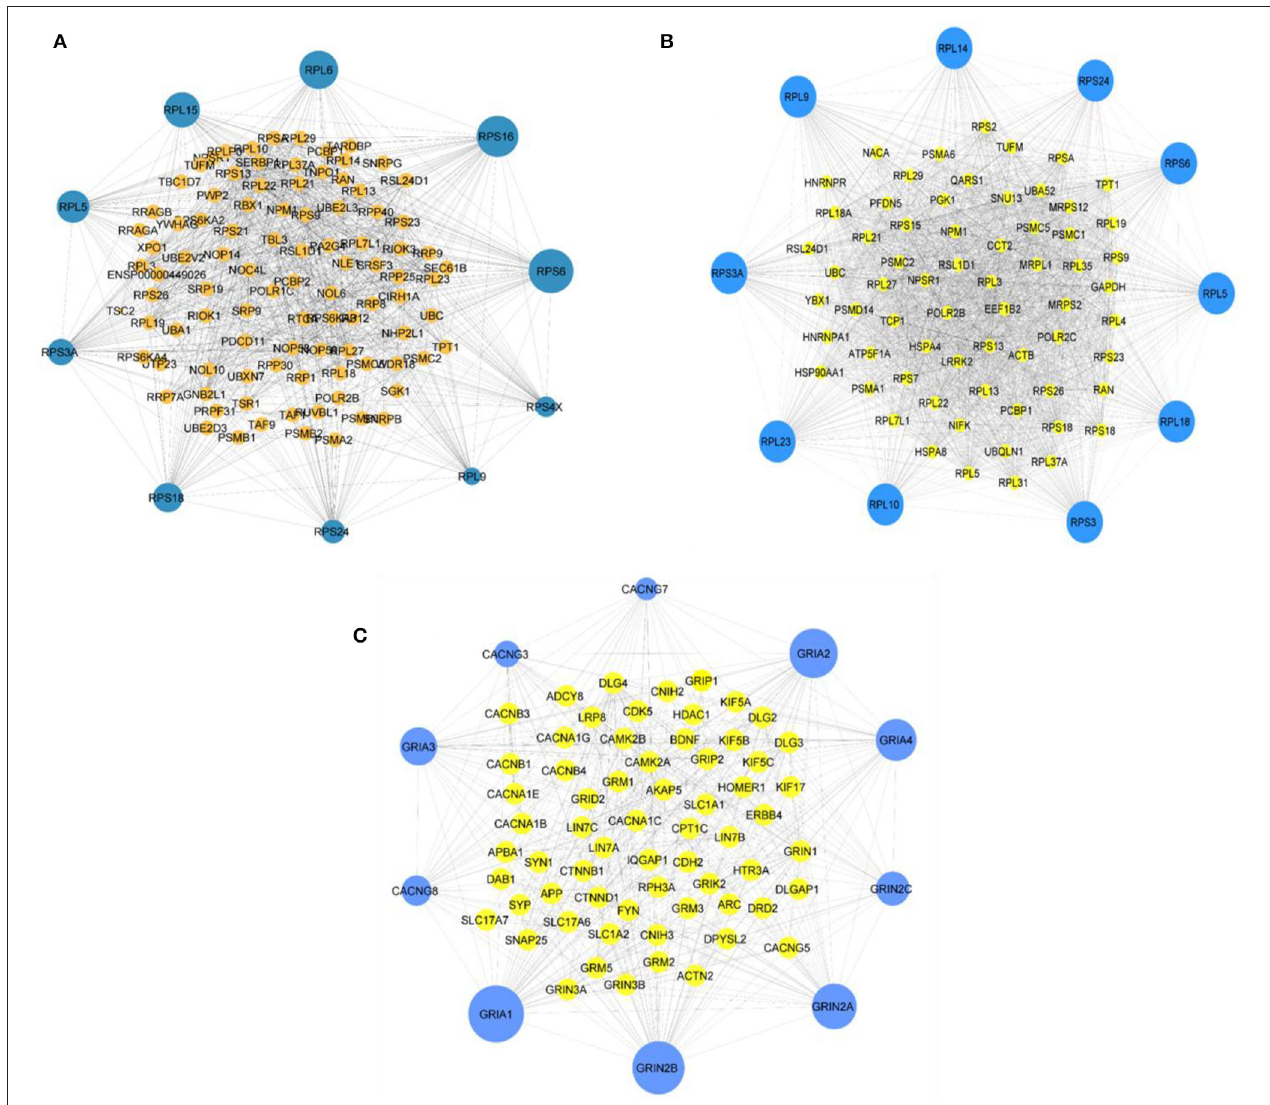
FIGURE 4 | (A) The topmost 10 hub genes for symAD vs. AsymAD (B) the top 10 hub genes for symAD vs. control, and (C) the top 10 hub genes for AsymAD vs. control selected the MCC scores using CytoHubba plugin in Cytoscape.